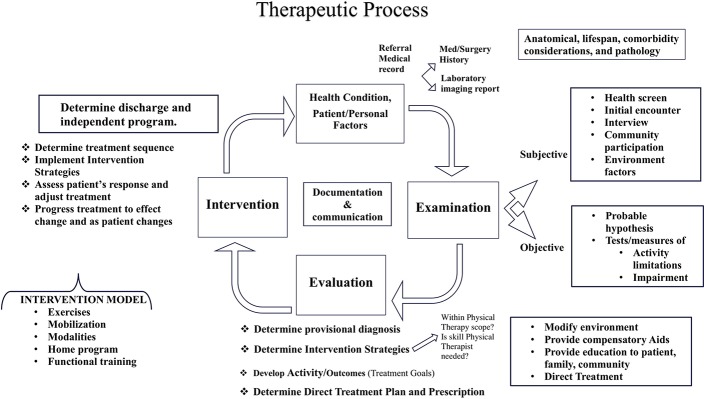
Therapeutic process.